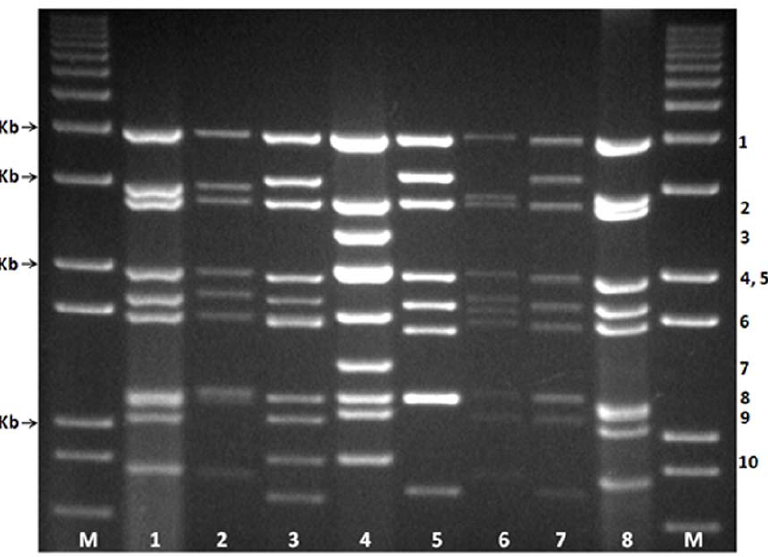
Figure 1. Agarose gel (1%) profile of dsRNA of Umatilla virus along with other orbiviruses. M: 1 Kb DNA Marker, 1: BTV-1 (LIB2007/07); EHDV-6 (USA2006/05); PALV (SUD1983/09); AHSV-1 (RSArah1/03); PHSV (PER1997/01); EEV (RSA1967/02) and BTV-15 (RSArrrr/15) (Figure 1).